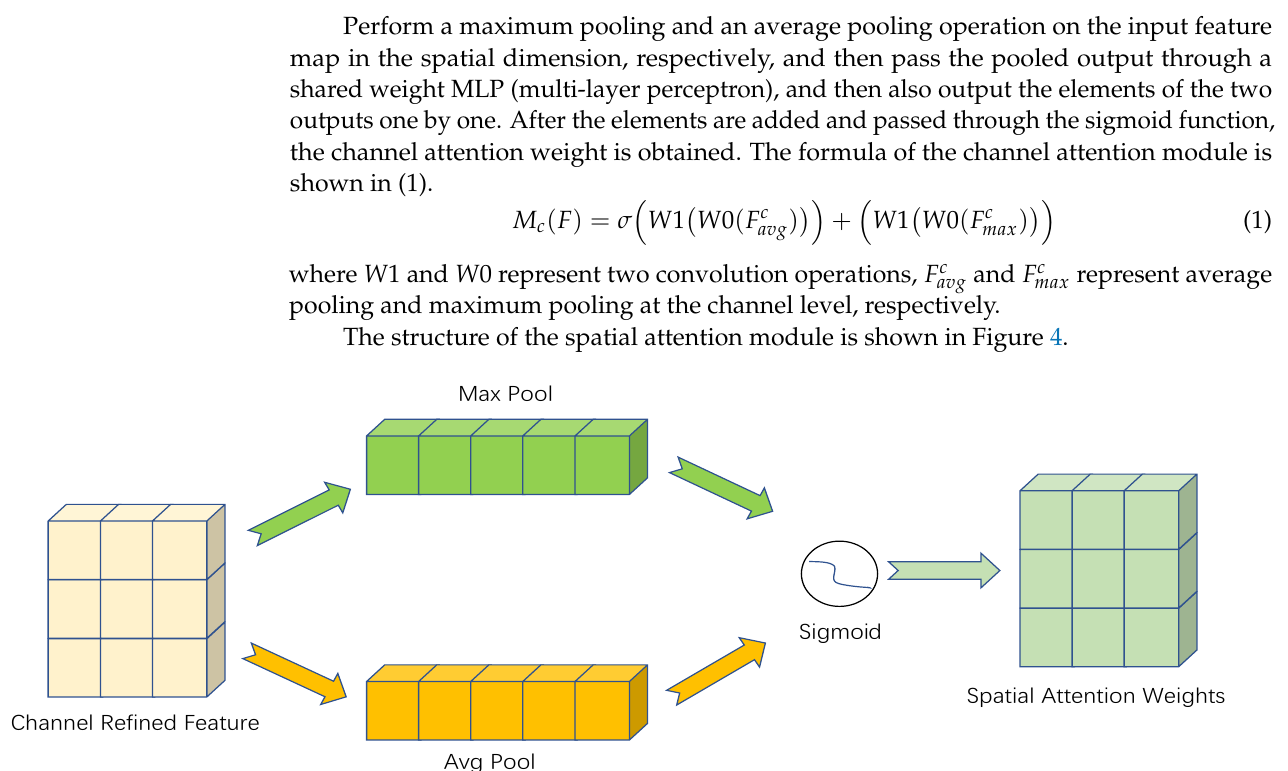
Figure 3. Channel attention module.